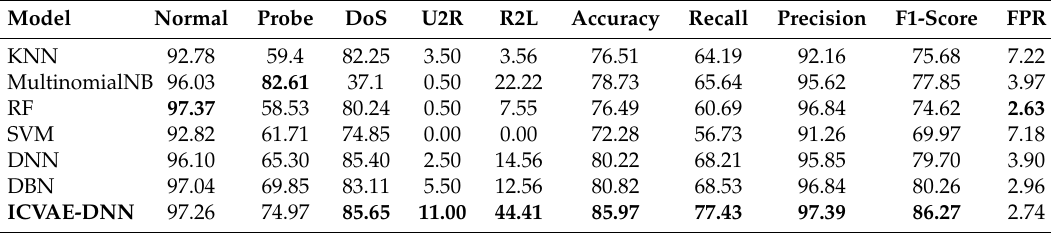
Table 9. Comparison of detection performance for different classification methods on the NSL-KDD (KDDTest+) dataset (%).